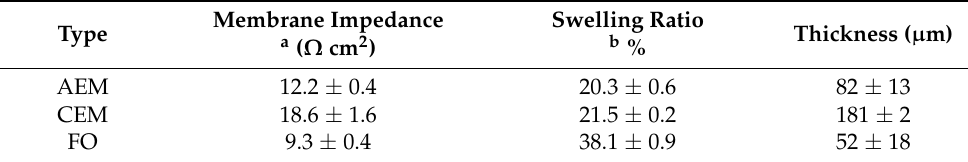
Table 1. Test results of the membrane